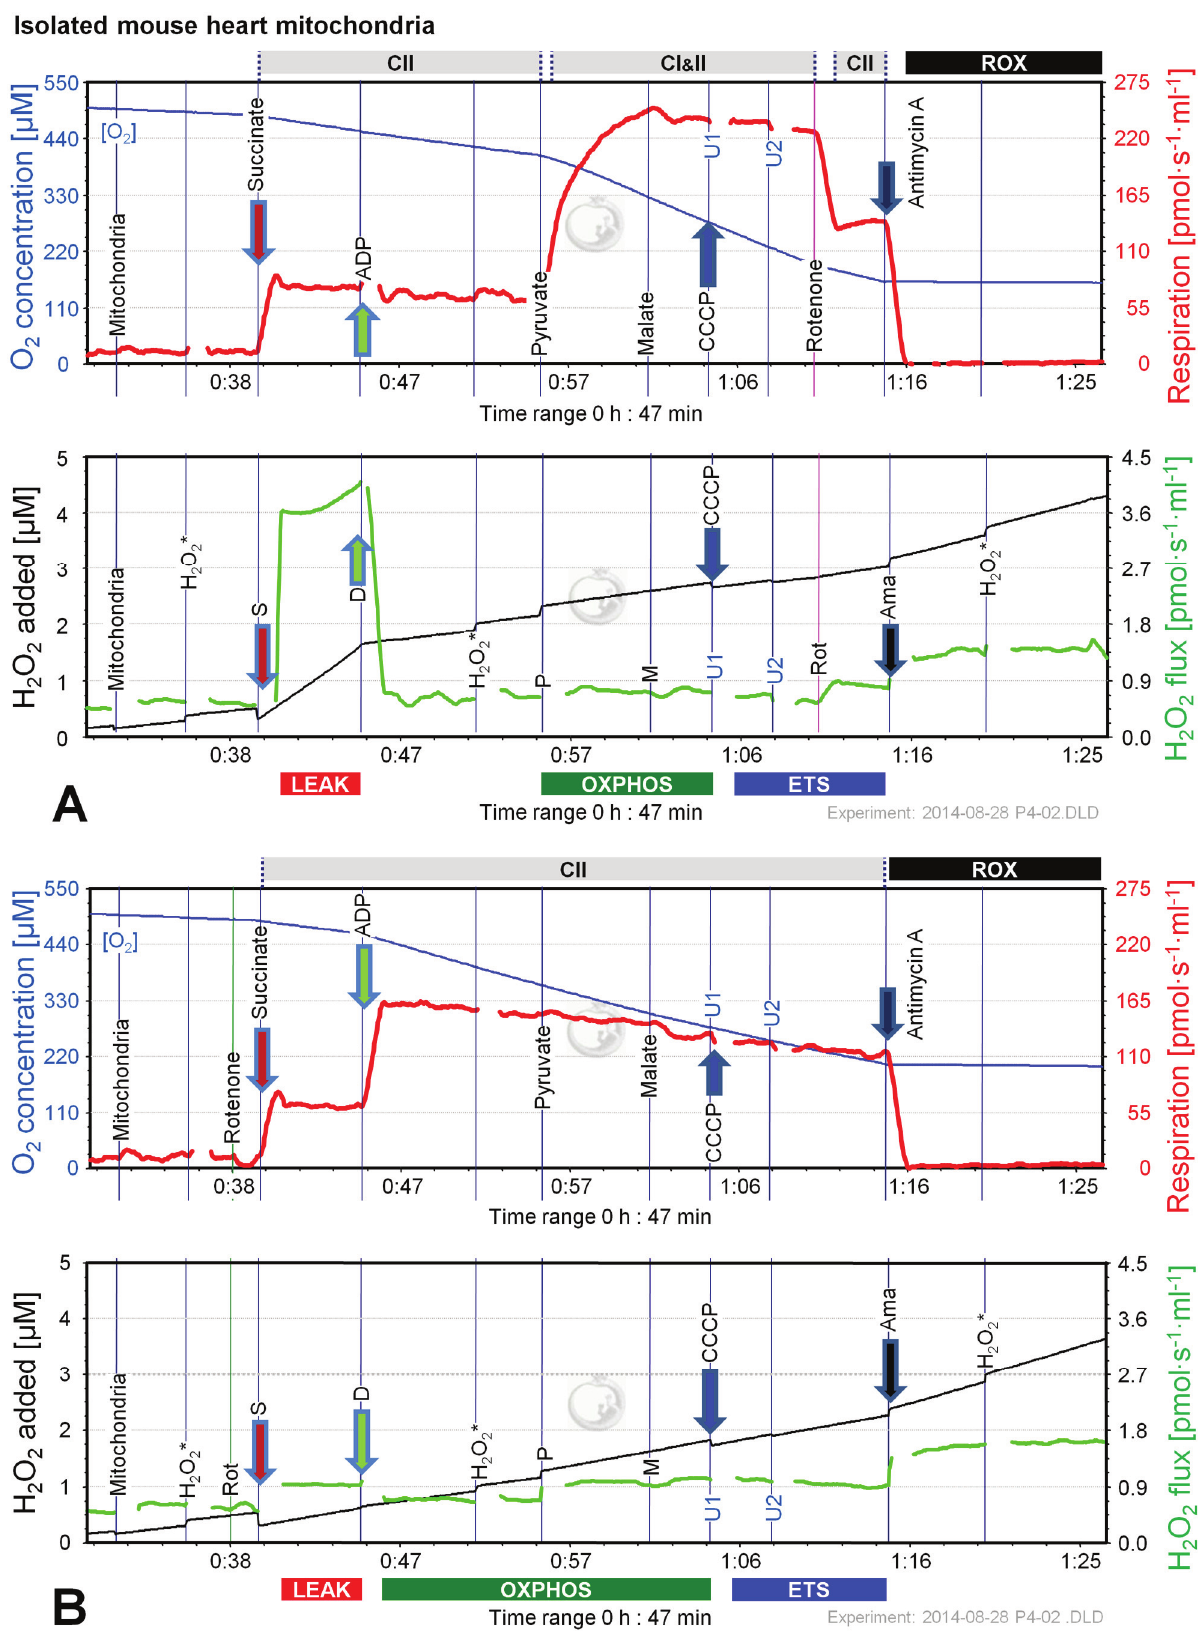
Figure 8. Combined determination of oxygen consumption and H 2 O 2 production by O2k-Fluorometry in mouse isolated cardiac mitochondria, using S ( A ); or S(Rot) ( B ) as initial substrate. For details see legend of Figure